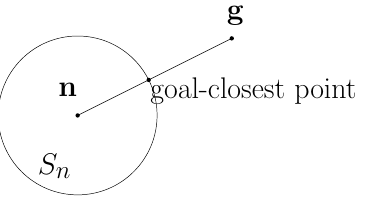
Figure 2. S n meets L ( n , g ) at one point, called the goal-closest